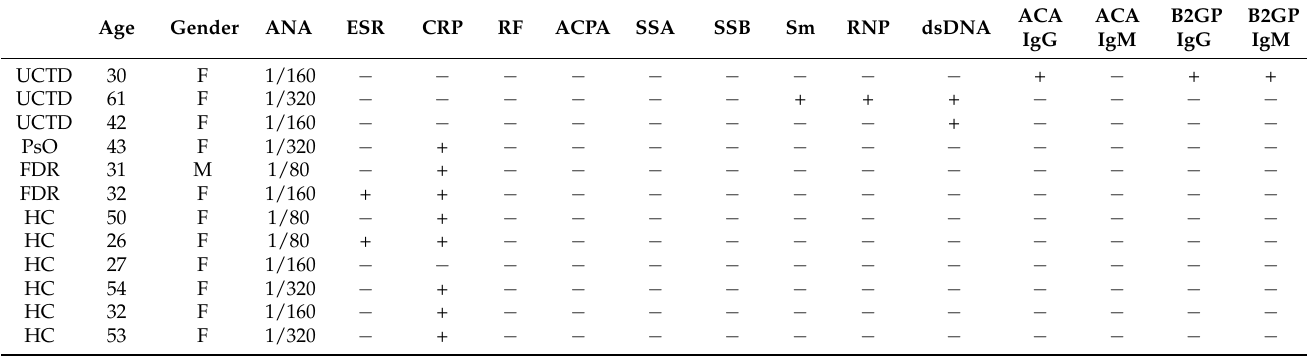
Table 2. Clinical and demographical variables for ANAS/DFS70 patients n =